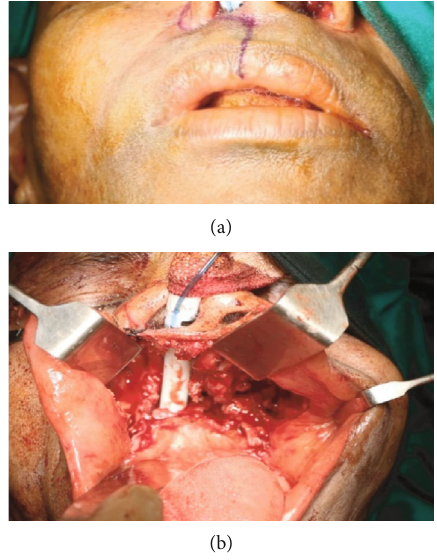
Figure 10: (a, b) Maxillectomy procedure done under local anesthesia.